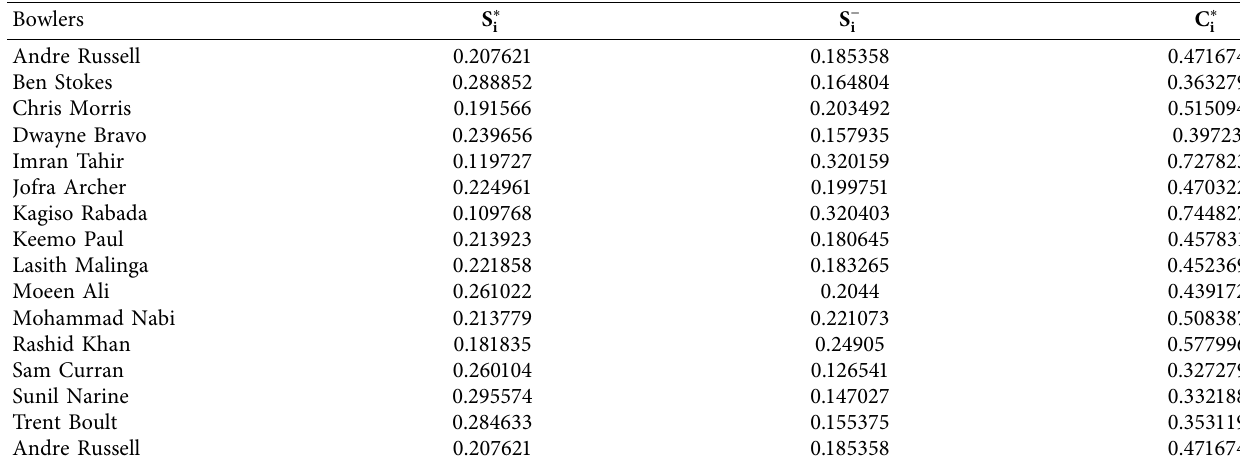
Table 8: Distance values for